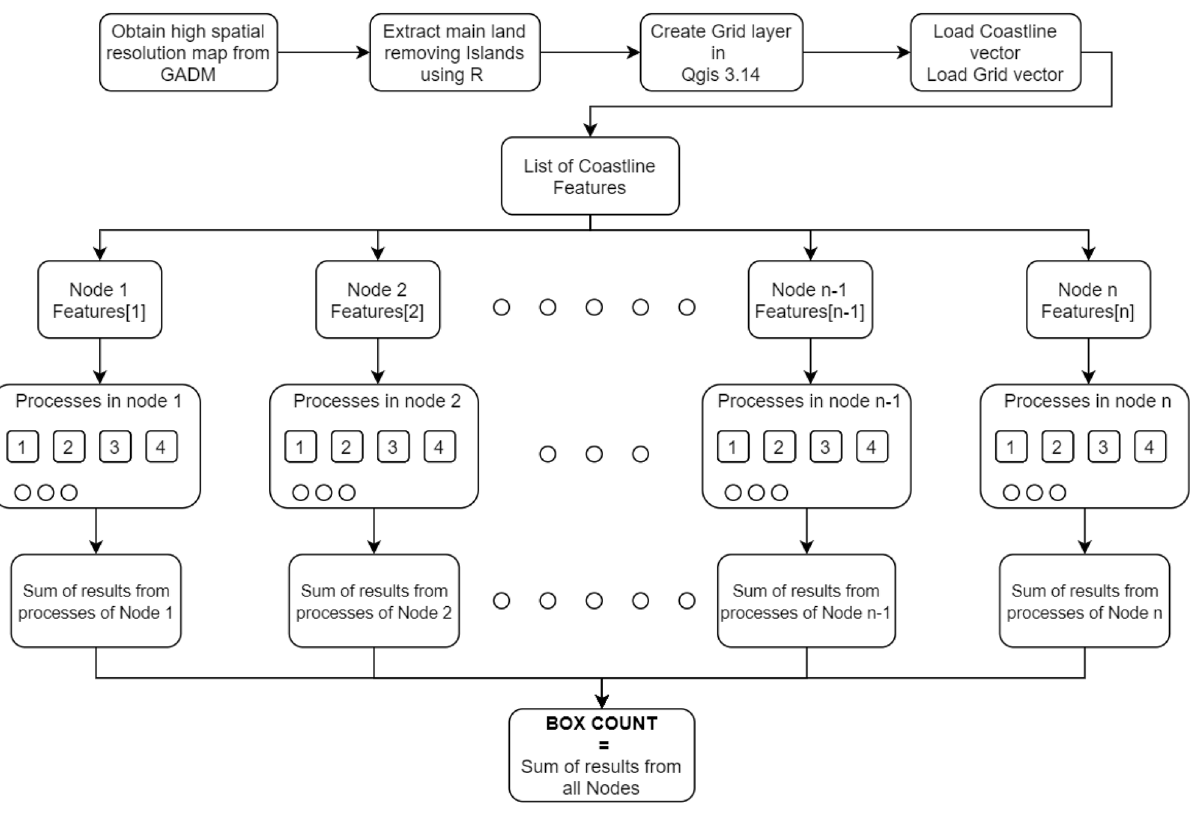
Figure 4. Flow chart of the parallel implementation.